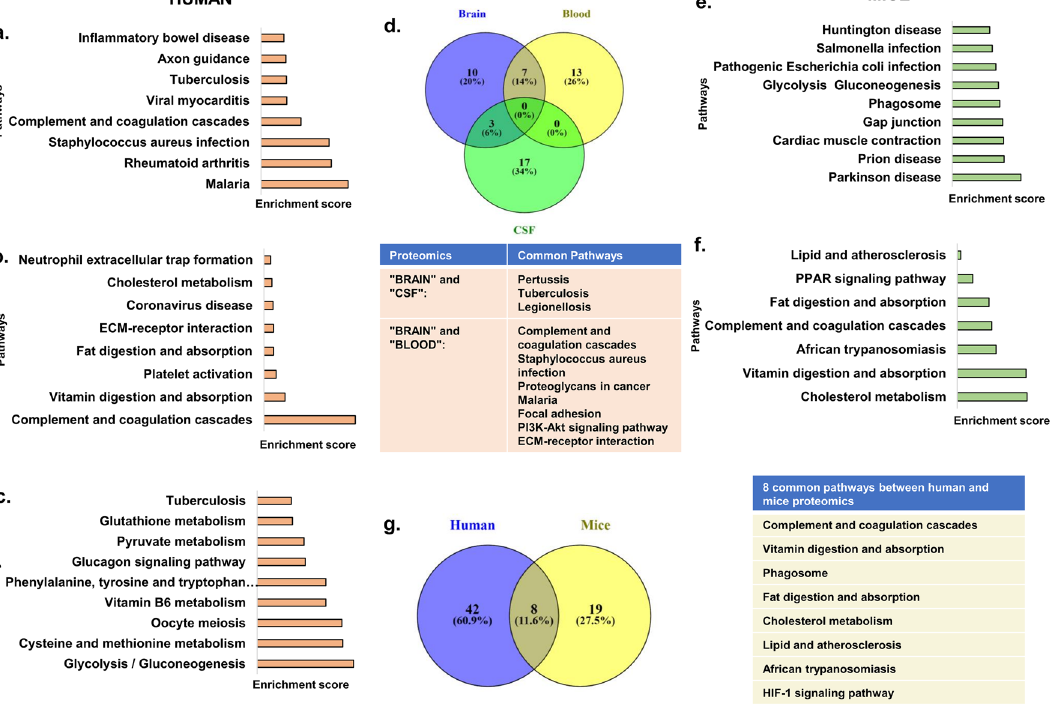
Figure 3. Pathway analysis of differentially expressed proteins (DEPs) between healthy controls and Alzheimer’s patients using Enrichr tool. Top significant pathways from datasets of ( a ). Brain ( b ). Blood serum ( c) . Cerebrospinal fluid (CSF) ( d) . Common proteomics pathways in humans. Proteomics analysis of mice datasets ( e). Brain ( f) . Blood ( g). Common proteomics pathways between humans and mice. Figure generated using Venny (bioinfogp.cnb.csic.es/tools/venny/), Microsoft power point 2019 MSO (Version 2212 Build 16.0.15928.20196)